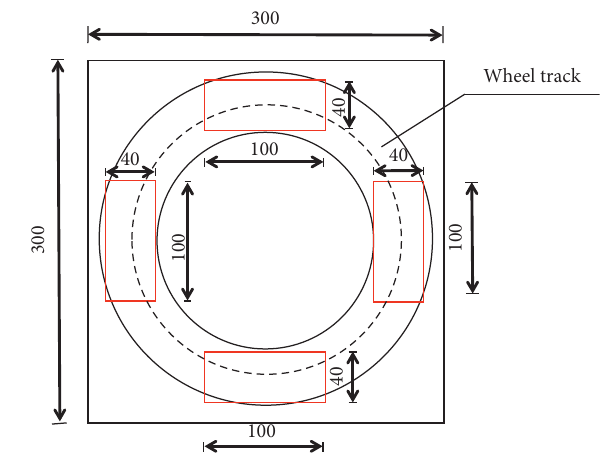
Figure 2: Scanning area on the